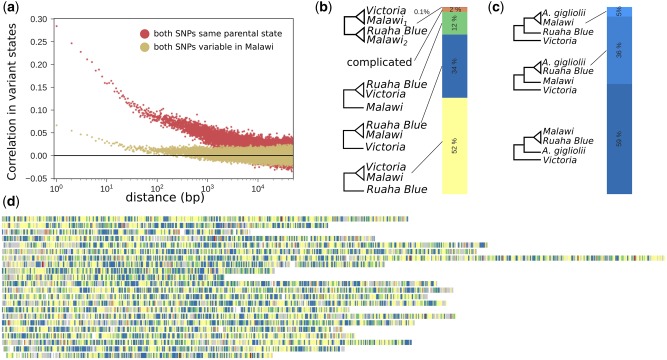
Correlation in variant states and distribution of relatedness patterns along the genome. (a) Genome-averaged excess probability that two SNPs of a certain physical distance that are differentially fixed between Victoria and Ruaha Blue are of the same state in Malawi. Red dots: joint probability that two variants in Rhamphochromis woodi at the given distance are homozygous for the same parental state (Victoria or Ruaha Blue) minus the expectation if the two variant states were independent (Materials and Methods). Golden dots: joint probability that two variants at the given separation are variable in Malawi minus the expectation if the two variants were independent (Materials and Methods). (b) NJ trees of all samples were constructed in overlapping 5-kb windows (1 kb step size) and rooted with the Tanganyikan outgroup Neolamprologus brichardi. Shallow trees with <5 SNPs separating the common ancestor of Victoria, Malawi, and Ruaha Blue from all the tips of at least two of these groups were excluded (10% of the windows). The remaining trees were classified into five mutually exclusive patterns: 1) All Malawi samples are more closely related to all Victoria samples than to any Ruaha Blue sample (yellow); 2) all Malawi samples are more closely related to all Ruaha Blue samples than to any Victoria sample (blue); 3) all Victoria samples are more closely related to all Ruaha Blue samples than to any Malawi sample (green); 4) some Malawi samples are more closely related to all Victoria samples than to any Ruaha Blue sample, whereas other Malawi samples are more closely related to all Ruaha Blue samples than to any Victoria sample (red, 0.1% of the windows); and 5) more complicated relatedness patterns (brown). (c) Subclassification of pattern (2) into cases (from dark to light blue): All Malawi samples are closer to all Ruaha Blue samples than to any A. gigliolii sample; at least some A. gigliolii samples are closer to Ruaha Blue; all Malawi samples are closer to all A. gigliolii samples than to any Ruaha Blue sample. (d) Distribution of relatedness patterns along chromosomes. Regions with “shallow trees” (see above) are shown in gray.